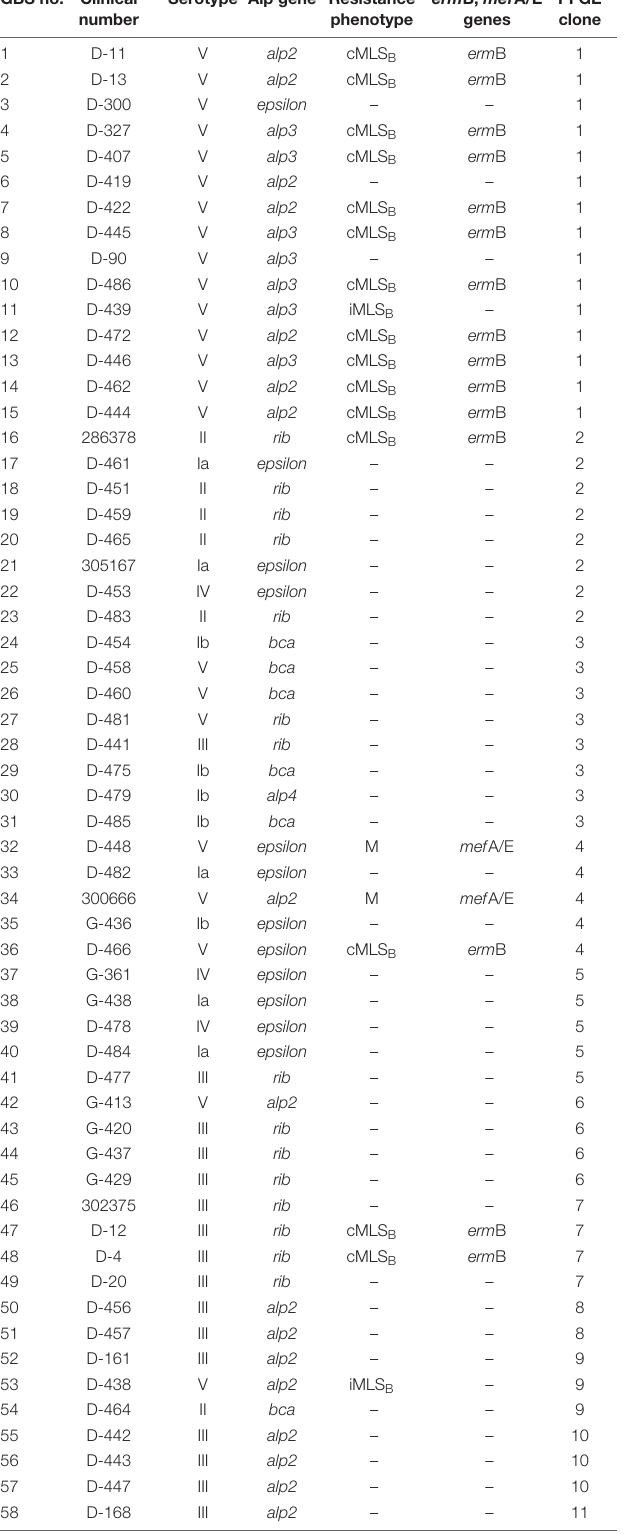
TABLE 1 | Summary of molecular and phenotypic properties of clinical GBS strains isolated from patients with UTI. GBS no. Clinical